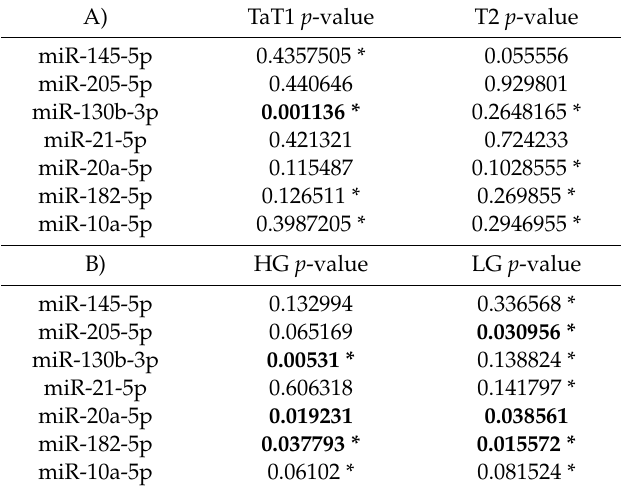
Table 2. Di ff erences in expression in A) stage TaT1 and T2 according to di ff erent grade and B) low and higf grade tumors according to stage of BC.